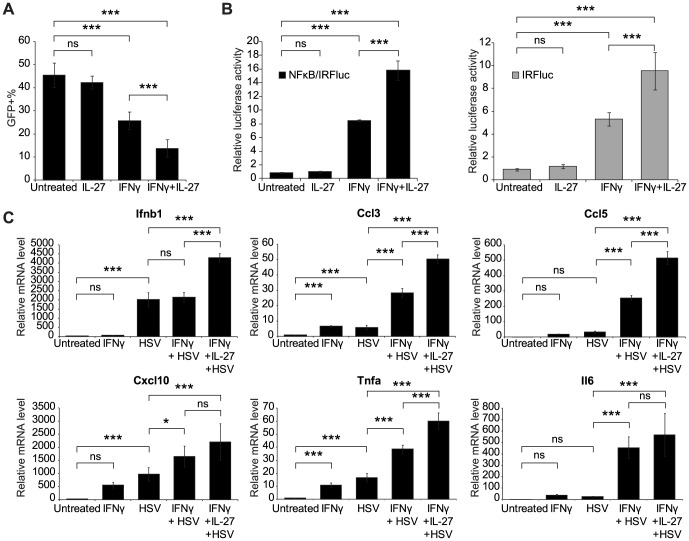
IL-27 functions cooperatively with IFN-γ to suppress the infection of HSV-GFP.
(A) Cells were seeded in 96-well glass-bottom plates and either left untreated or treated with recombinant IL-27 alone (50 ng/ml), IFN-γ alone (10 ng/ml) or IL-27 + IFN-γ for 16 h. After infecting cells with HSV-GFP overnight, cells were fixed, stained with nuclear acid stain and subjected to imaging. Percentage of GFP-positive cells in each treatment group was calculated and graphed. Data shown are results from 4 independent experiments. (B) NF-κB/IRF and IRF reporter cells were seeded and treated as in (A). After stimulating with IL-27 and/or IFN-γ for 16 h, cells were lysed and luciferase activities measured. The reporter luciferase activity in untreated cells is normalized to 1. Data shown are results from 3 independent experiments. (C) Cells were seeded and treated as in (A). After infecting cells with HSV-GFP for 6 h, RNA was isolated and qRT-PCR was performed to examine the relative expression levels of downstream effector genes. All expression levels are relative to the level of untreated control and Gapdh was used as internal control for normalization. Data shown are results from 3 independent experiments. ns, not significant; ***P<0.001; *P<0.05 by one-way ANOVA with Bonferroni post-test.